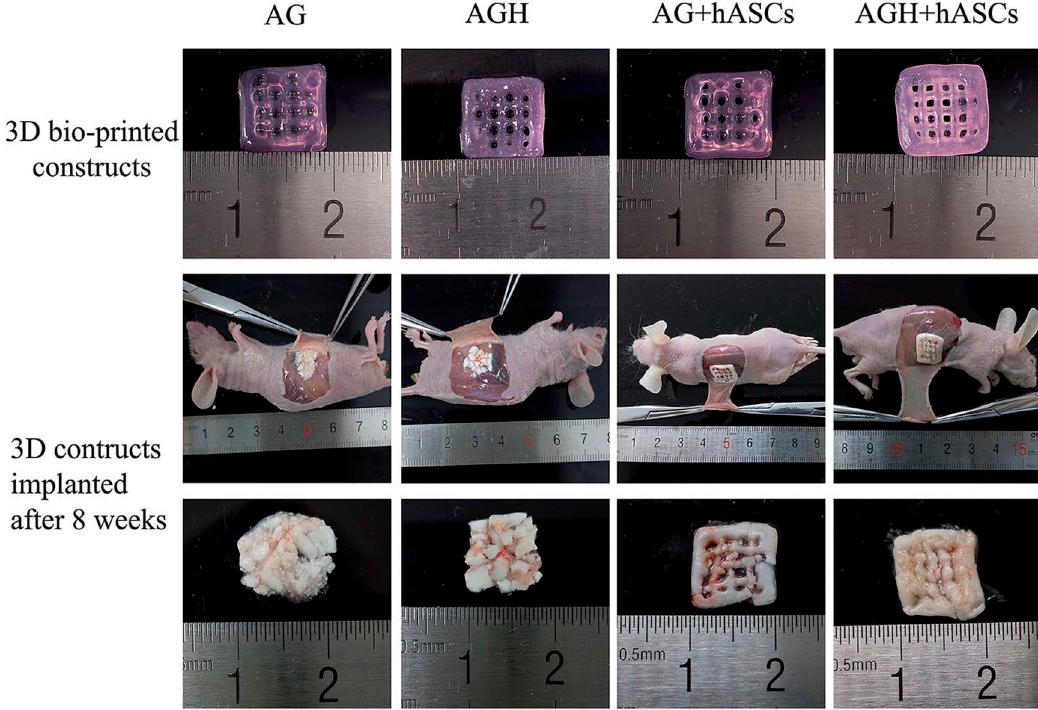
Figure 10. 3D bio-printed constructs made of alginate/gelatin (AG) and alginate/gelatin/nano-HAp (AGH) mixed with human adipose-derived stem cells (hASCs) before and after implantation showing osteoinduction. Constructs were implanted into the back sub-cutaneous area of nude mice and harvested eight weeks after surgery. Larger bone formation was observed in the constructs containing HAp. Reproduced from [140] with permission, Copyright (2016) Royal Society of Chemistry.